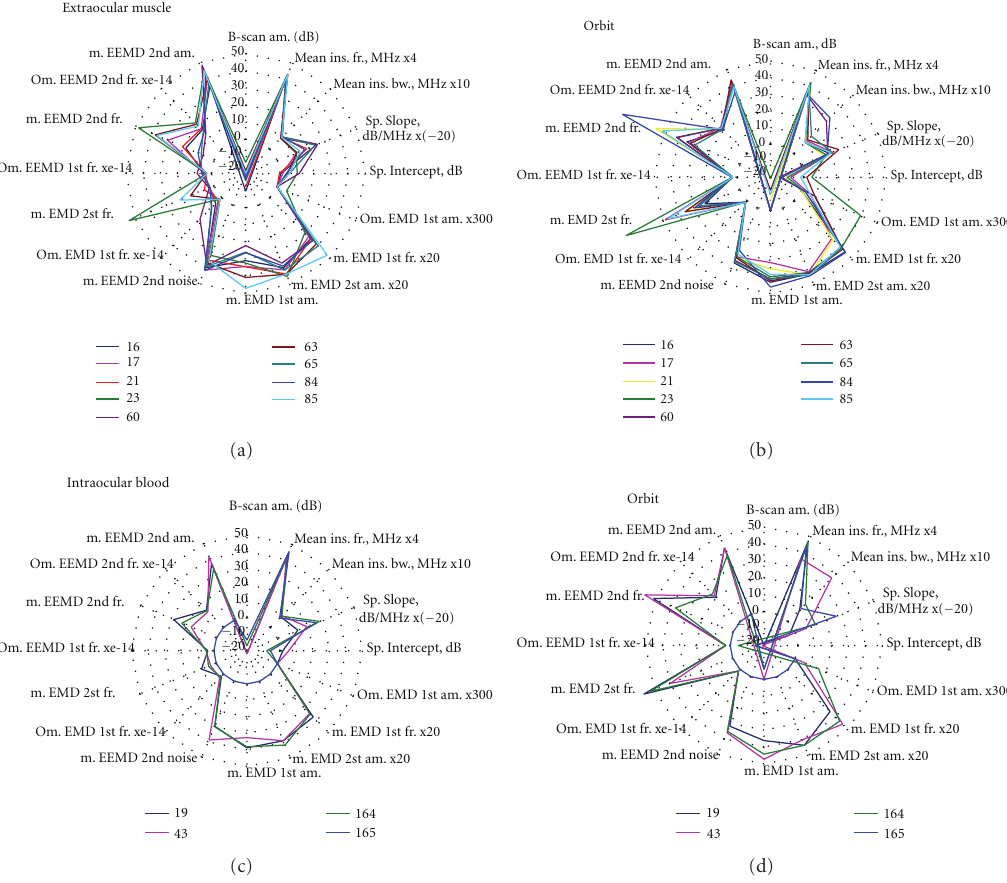
Figure 3: The distribution of parameter values for tissues di ff erentiation: (a) healthy extraocular muscle (b) healthy orbit tissue (of the same eye); (c) blood inside the eyeball (d) healthy orbit tissue (of the same